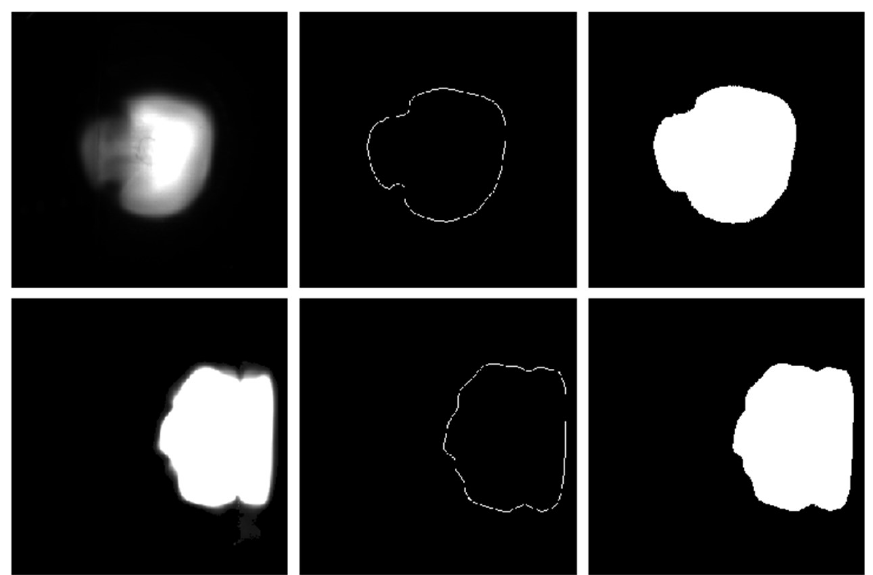
Figure 2. The image ( left ), the boundary ( middle ), and the area ( right ) of one pure aluminium plasma spark. The upper images were from the X direction, and the lower ones were from the Y direction.